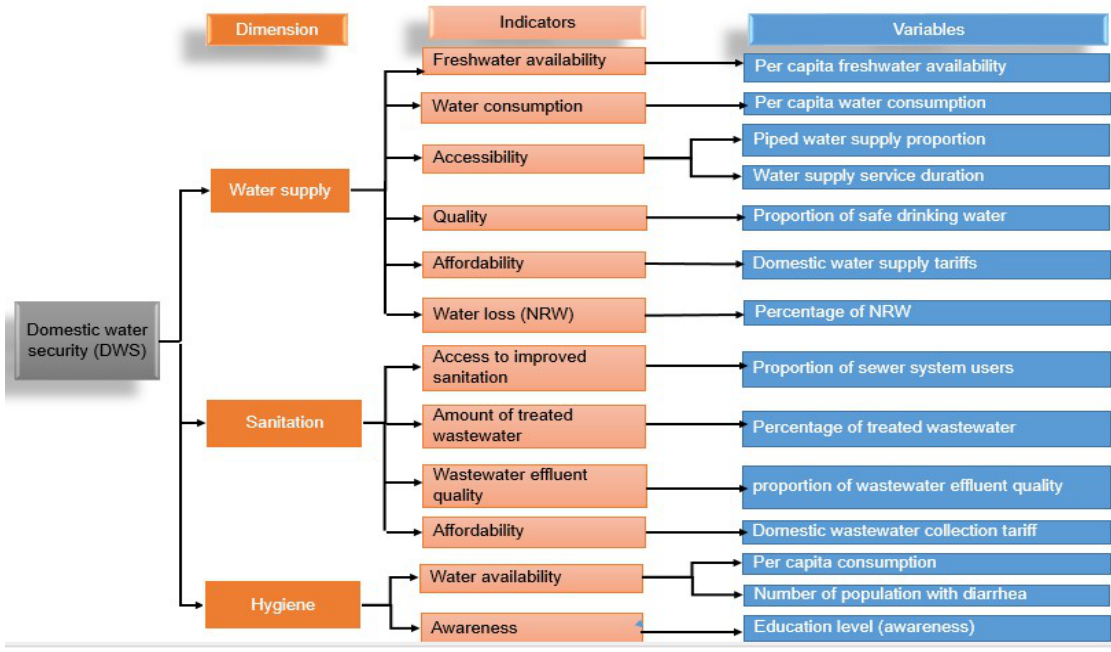
Figure 1. The developed domestic water security index framework.